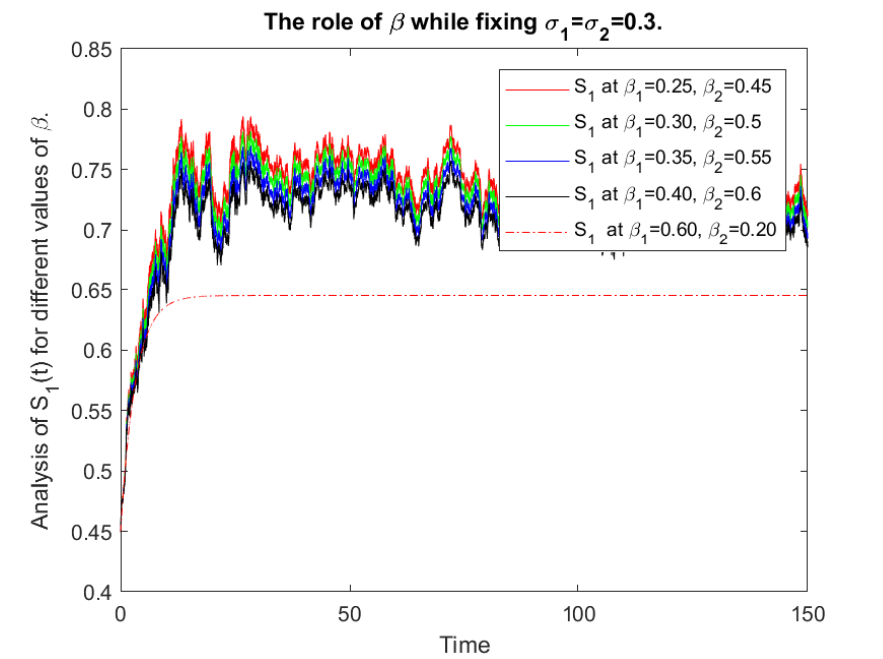
Figure 12. Comparative analysis of S 1 ( t ) .